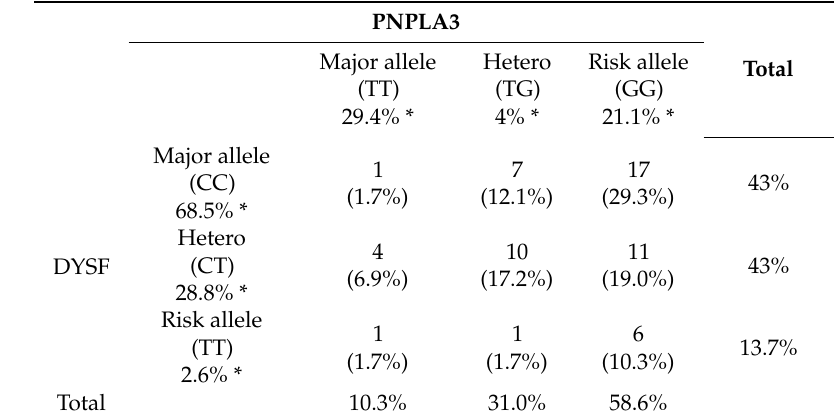
(1.7%) (1.7%) (10.3%) Total 10.3% 31.0%